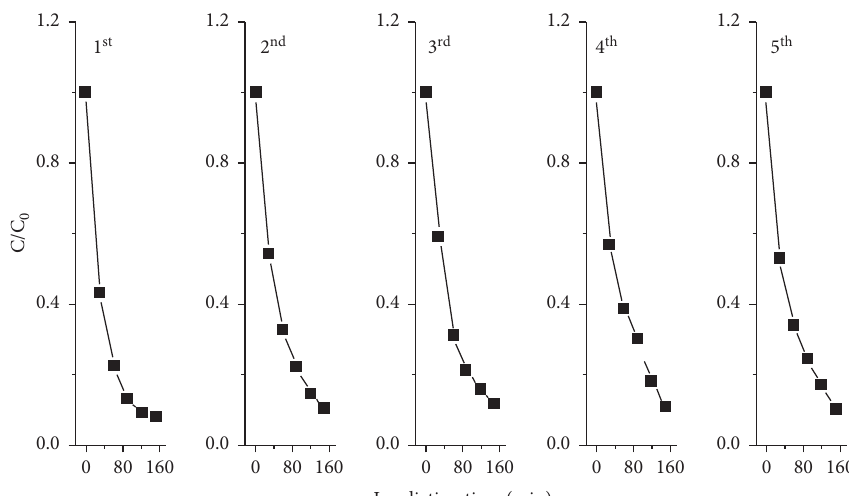
Figure 12: Repeated photocatalytic decolorization experiments of MO over the Ag